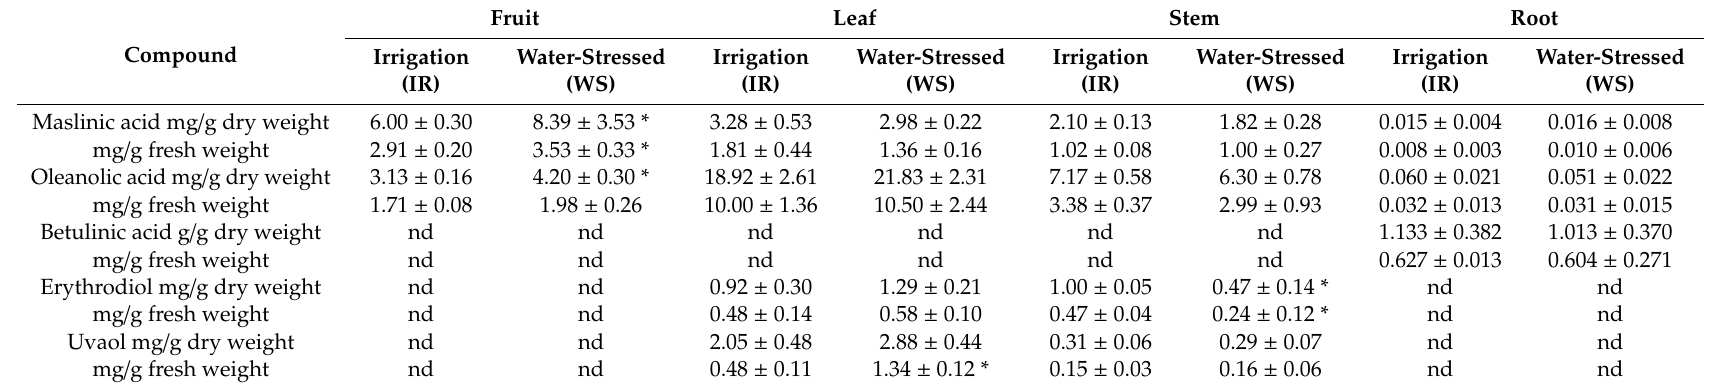
Values are means ± standard error of the mean. In each row and / or each organ, for comparisons between the irrigation and water stress conditions, values followed by * are significantly di ff erent ( p <